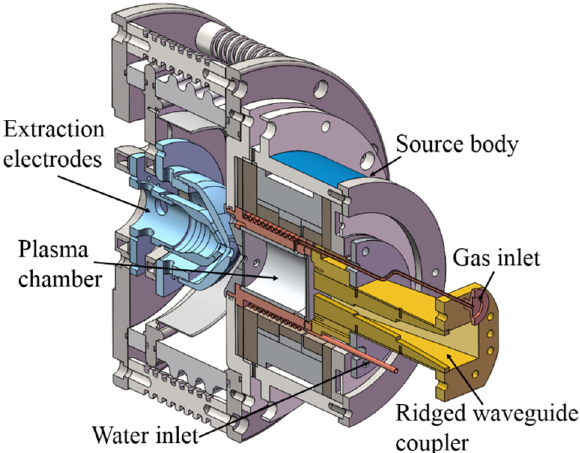
Figure 6. Configuration of the designed intense ion beam source.